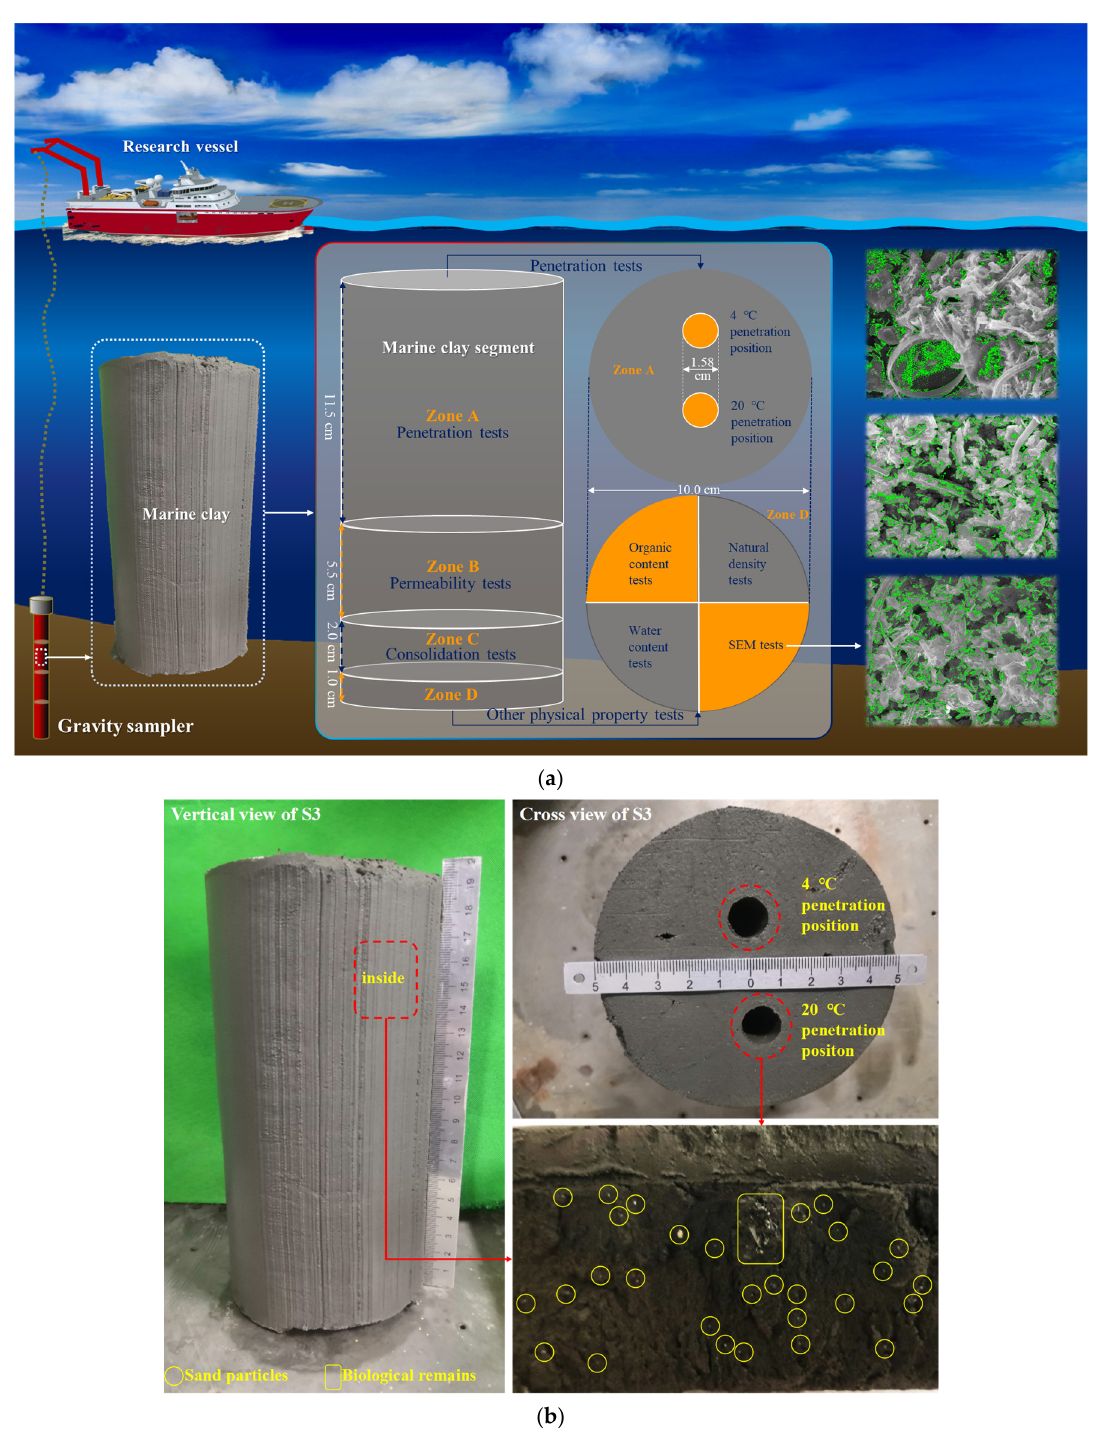
Figure 1. Diagram and physical map of the sediment segments: ( a ) Schematic diagram of the spatial layout of penetration and physical property tests of each sediment segment; ( b ) Physical map of a 100–150 cm sediment segment (S3).